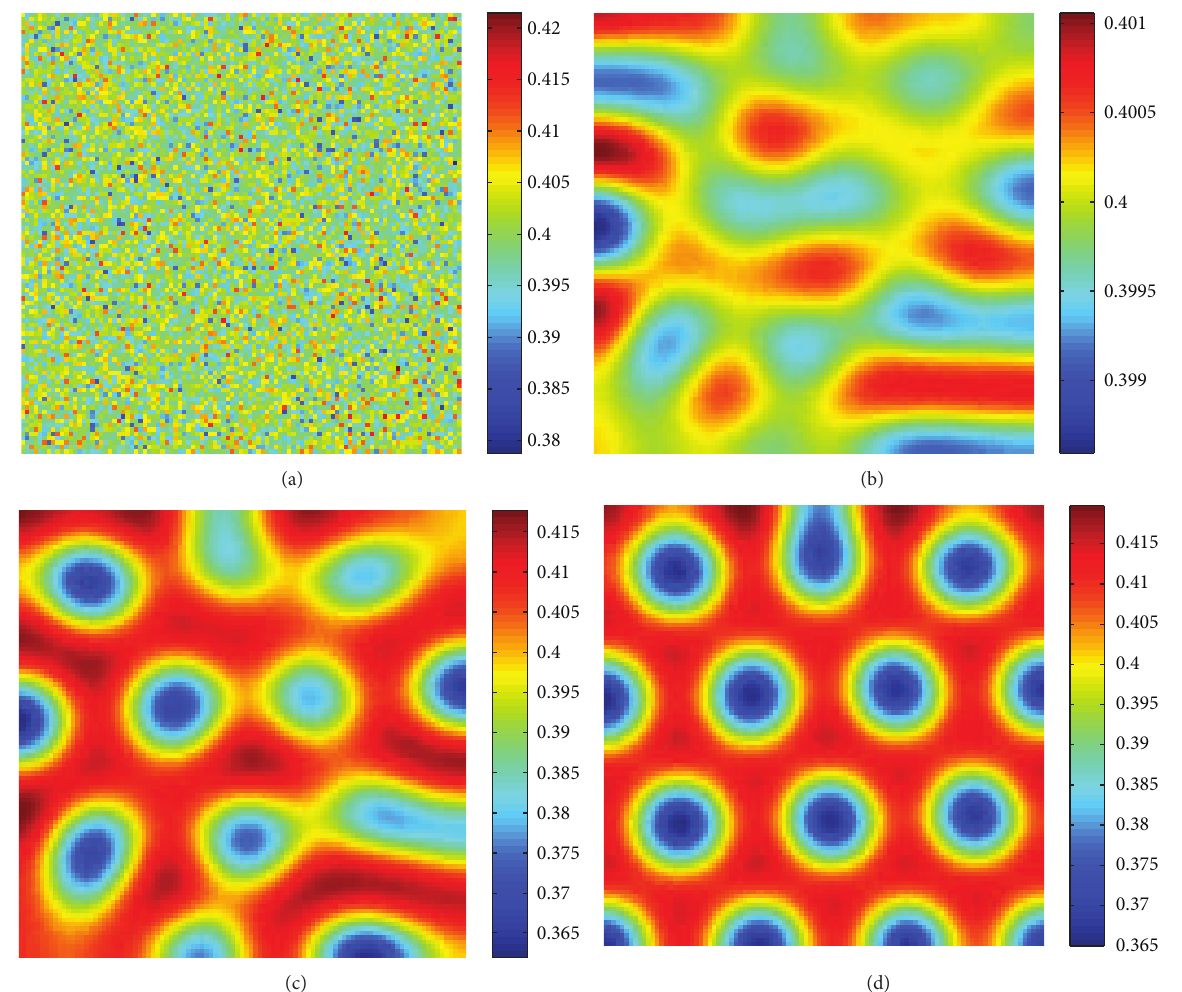
Figure 3: The formation of holes patterns of prey 𝑢 with parameters 𝑏 = 0.4, 𝑐 = 0.5, 𝑘 1 = 0.3, 𝑘 2 = 0.2, 𝑚 = 0.24, 𝑠 = 0.25, 𝑑 1 = 0.1 , and = 2 . Time: (a) 𝑡 = 0 , (b) 𝑡 = 300 , (c) 𝑡 = 1000 , and (c) 𝑡 = 3000 𝑑 2